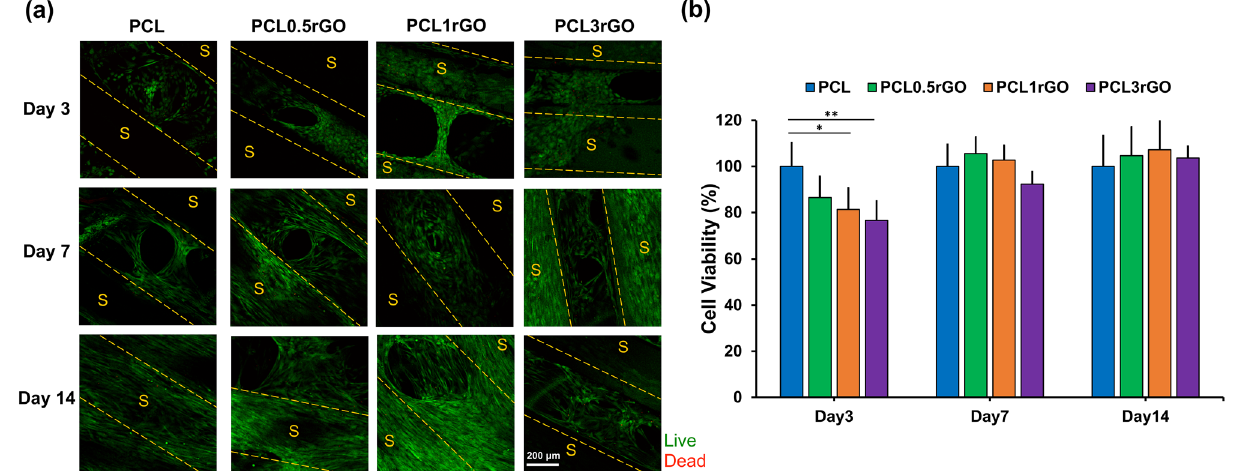
Figure 8. Cytocompatibility of the 3D printed scaffolds. ( a ) Representative confocal micrographs of hADSCs grown on the 3D printed scaffolds and stained with the fluorescent live/dead assay (green, calcein AM; red, ethidium homodimer-1). The strand borders are identified using dashed lines (scale bar 200 μm). ( b ) Cell viability of hADSCs on the 3D printed scaffolds, measured by the MTS assay. Results are expressed as % viability with respect to the PCL control at each time point and are presented as mean ± SD (n = 3) (*p < 0.05, **p <